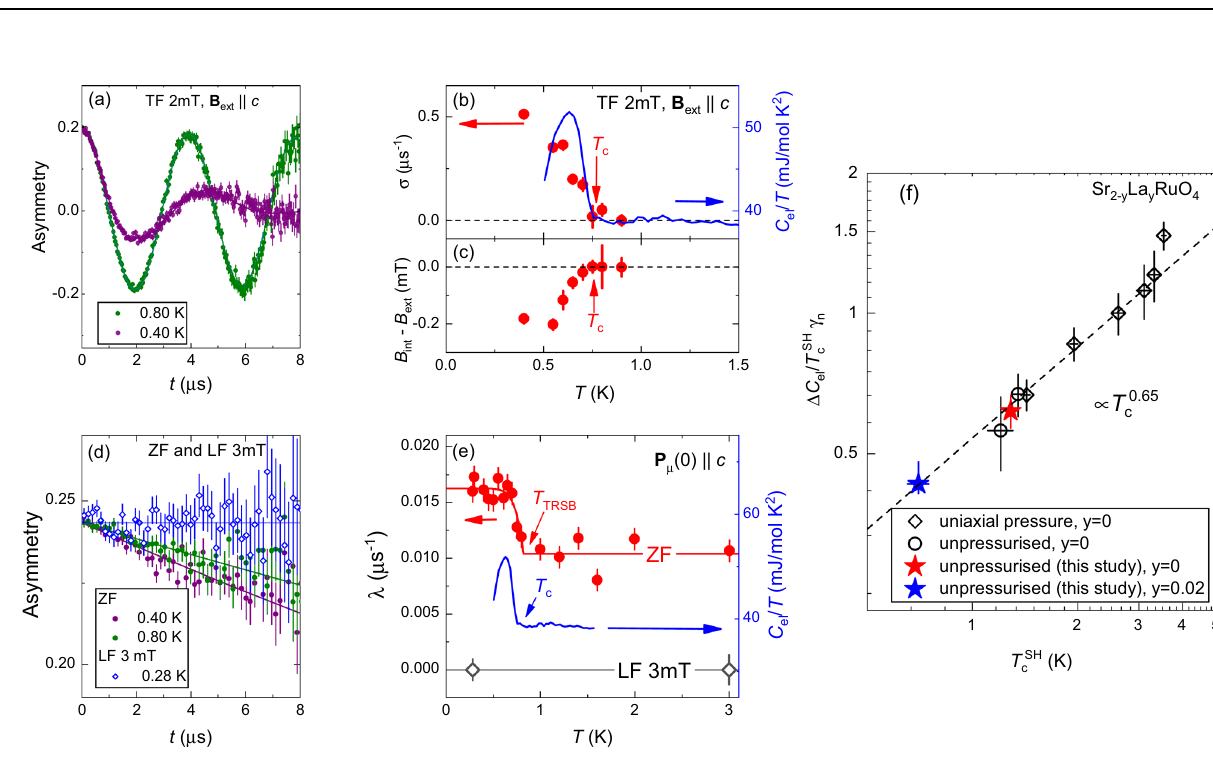
Fig. 3 TRSB in Sr 1.98 La 0.02 RuO 4 . a TF- μ SR time-spectra above and below T c measured at B ext = 2 mT with B ext ∥ c . The solid lines are fi ts of Eq. (3) to the data. b , c Temperature dependencies of the Gaussian relaxation rate σ and the diamagnetic shift B int − B ext , respectively. Arrows indicates the superconducting transition temperature T c , determined from the TF- μ SR data. The blue curve in b is the electronic speci fi c heat C el / T , measured on a small piece cut from the μ SR sample. d ZF- and LF- μ SR time-spectra. ZF data from above and below T c , measured with P μ (0) ∥ c , are shown. The LF data are from T well below T c , and with B ext = 3 mT ∥ P μ (0). The solid lines are fi ts of Eq. (8). e Temperature dependence of the ZF and LF exponential relaxation rate λ . The solid red line is the fi t of Eq. (1) to ZF λ ( T ) data. The blue curve is, again, C el / T . Arrows indicates positions of T c and T TRSB . f Double logarithmic plot of the normalised speci fi c heat jump Δ C el = γ T SH versus T SH [ γ n is the Sommerfeld coef fi cient and T SH is the transition temperature determined from C el / T ( T ) c c c n by means of equal-entropy construction, see Supplementary Fig. 1 in Supplementary Note 1]. Values of Δ C el = γ T SH are determined in a way presented in c n Supplementary Fig. 2 in Supplementary Note 1. Filled symbols: data from this work; open symbols: data taken from refs. 47,52 . The displayed error bars for μ SR data correspond to one standard deviation from the χ 2 fi t 71 . The error bars for Δ C = γ T SH and T SH indicate uncertainty in selecting the temperature el c c n range for linear fi t below T c however, within the range of previous results 47 . In qualitative ZF- μ SR data are presented in Fig. 3d, e. Fitting with Eq. (1) returns Δ λ = 0.007(1) μ s − 1 and T TRSB = 0.8(1) K. This Δ λ is agreement with data on a lower T c Sr 2 RuO 4 , reported in ref. 46 , noticeably smaller than that obtained from the undoped Sr 2 RuO 4 sample, corresponding to an internal fi eld B TRSB ≈ 0.01 mT. It is,